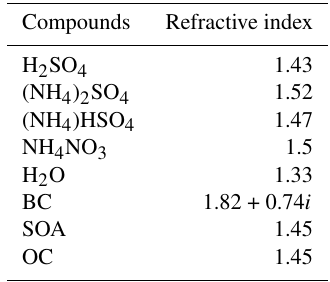
Table 2. Refractive indices of aerosol species at λ =